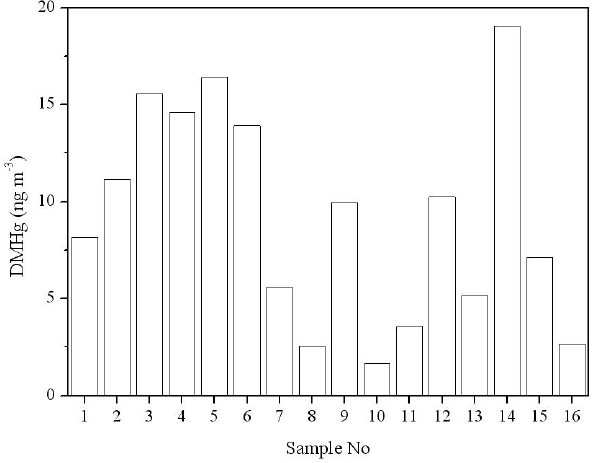
Fig. 11. DMHg in the LFG of selected vent pipes at G-Y